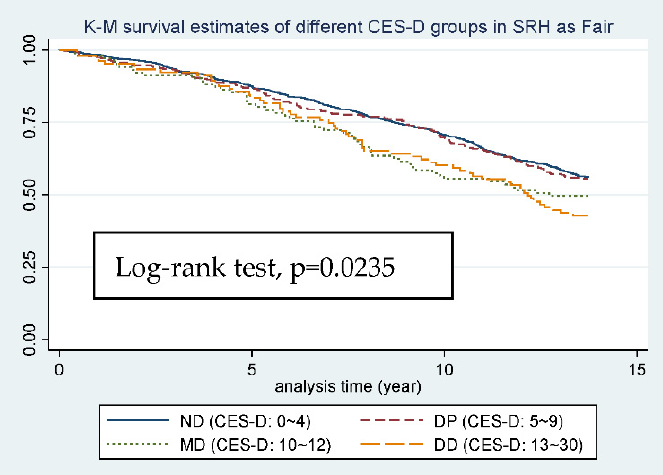
Figure 4. K-M survival estimates of different CES-D groups in SRH as Fair.